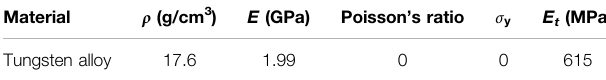
TABLE 5 | Material parameter for the tungsten alloy fragments.